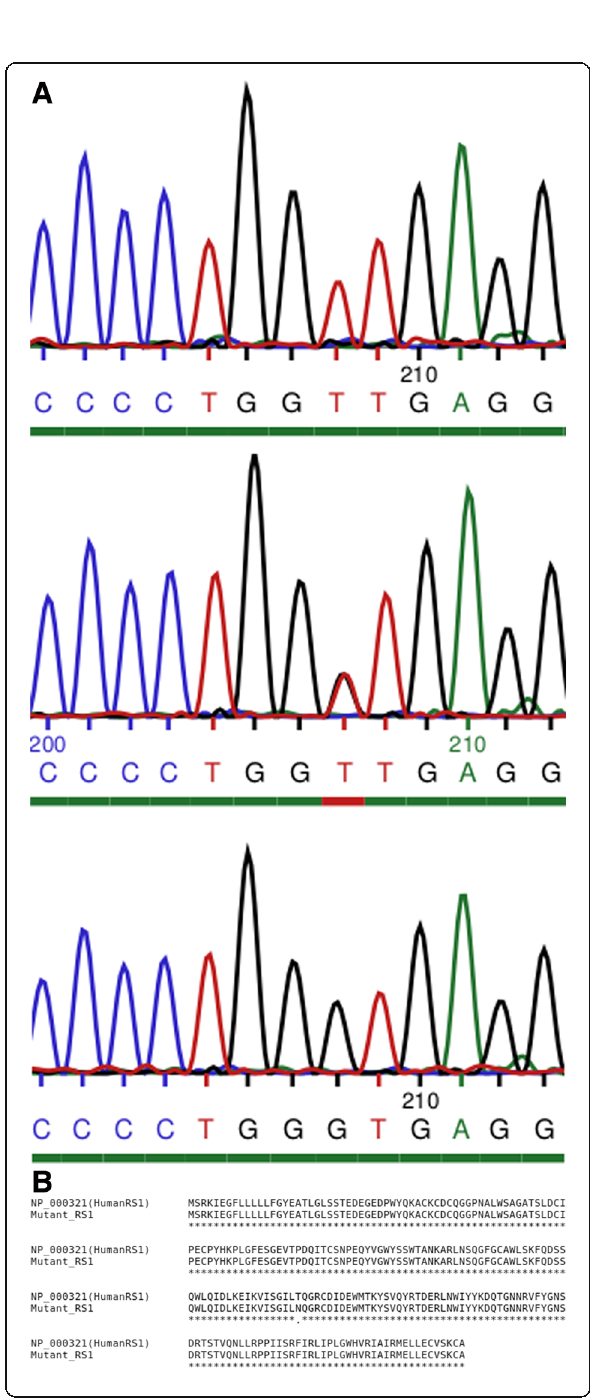
Fig. 4 a Sanger sequencing of RS1 -exon 5 polymerase chain reaction (PCR) products from members of the pedigree. Top: Sanger sequencing result for affected male (ID#1392) showing a T nucleotide trace at sequencing position 208. Middle: Sanger sequencing result for carrier female (ID#1534) showing a heterozygous result at sequencing position 207, revealing traces from both signals of wild-type G allele and the mutant T allele. Bottom: Sanger sequencing result for unaffected male (ID#1634) showing a G nucleotide trace at sequencing trace position 208. b Clustal Omega results for protein alignment of reference RS1 protein sequence against the observed mutant protein sequence. “ . ”